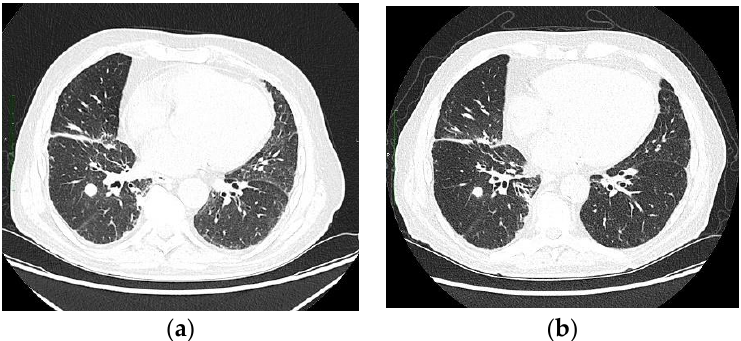
Scheme 2. Computed tomography performed at the time of progression during pembrolizumab maintenance therapy ( a ) and CT scans showing the effectiveness of the subsequent treatment with dabrafenib and trametinib ( b